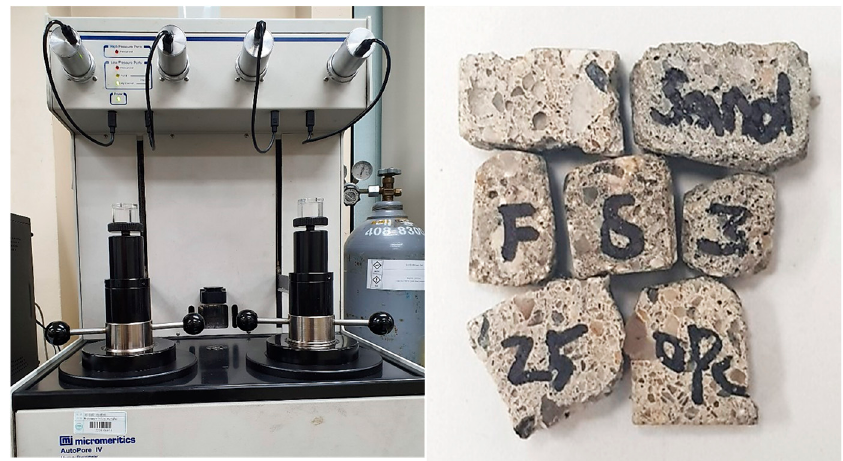
Figure 6. AutoPore IV series Automated Mercury Porosimeters.